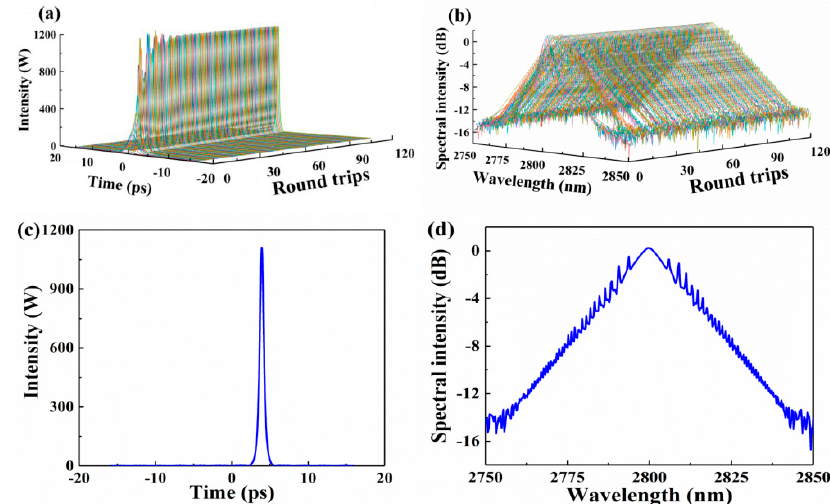
Figure 3. Pulse ( a ) and spectrum ( b ) evolution with round trips. Output pulse profile ( c ) and spectrum profile ( d ) in the 120th round trip.